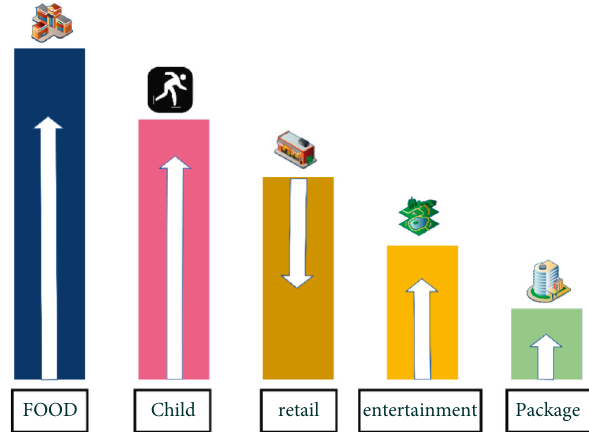
Figure 2: Comparison of shopping mall formats.